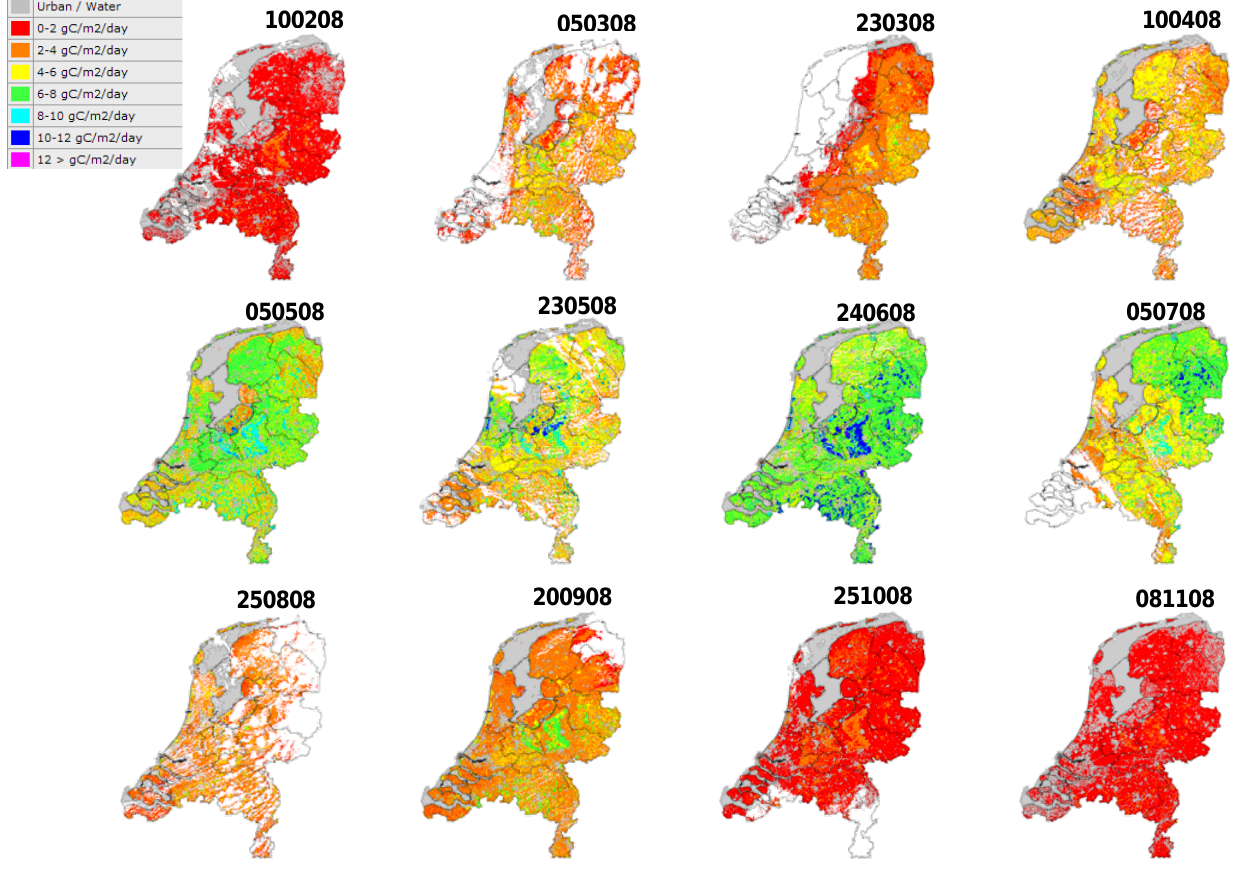
Figure 3. Monthly development of GPP (gC m -2 day- 1 ) over the Netherlands for the year 2008. The numbers above the maps refer to the date (ddmmyy) for which the map was